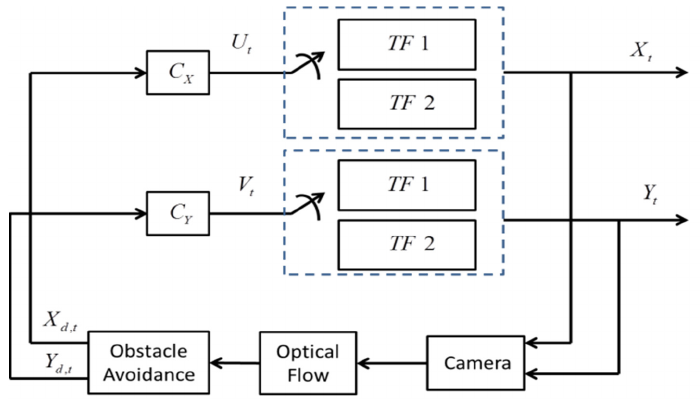
Figure 8. The structure of the switched system for MUAV visual servoing.